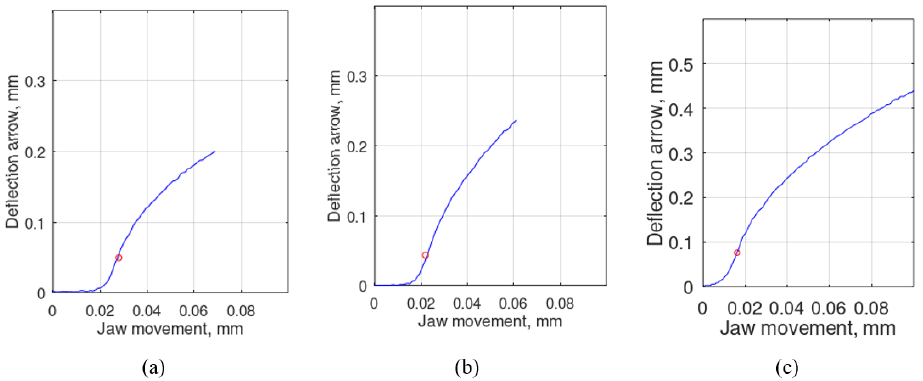
Figure 15. Dependence of the value of the deflection arrow on the displacement of the movable handle at the fastening lengths: ( a ) 3 mm, ( b ) 4 mm, (c ) 5 mm.